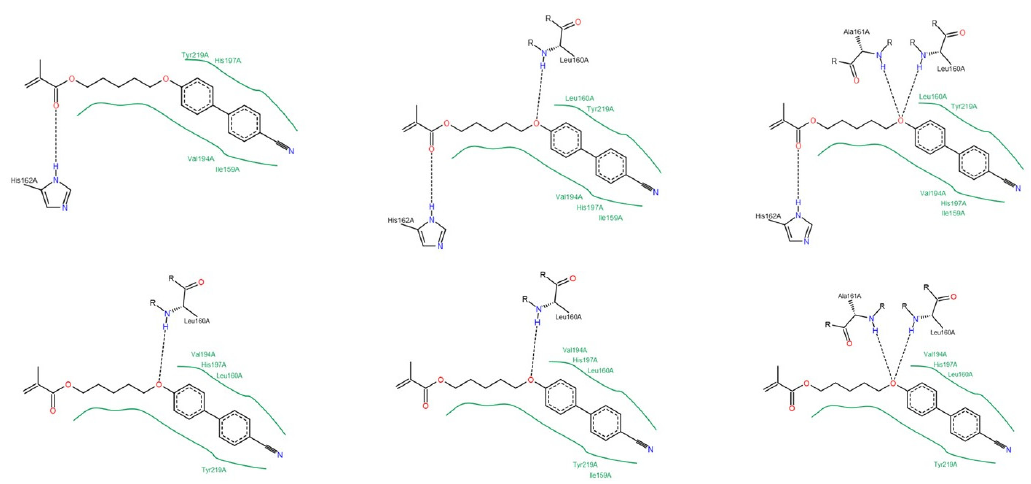
Figure A13. Interactions between compound B and MMP-8, by PoseView calculations.